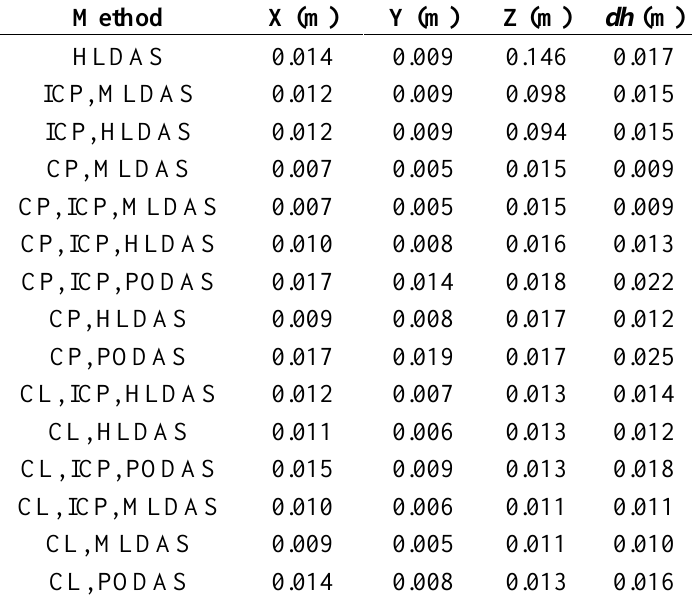
Figure 8. Average post-adjustment standard deviations for position components of georeferencing parameters for the Site 2 dataset for configurations that do not use artificial targets. Standard deviations were extracted from the a posteriori covariance matrix shown in Equation (10). Table 3. Checkpoint RMSEs for the Site 2